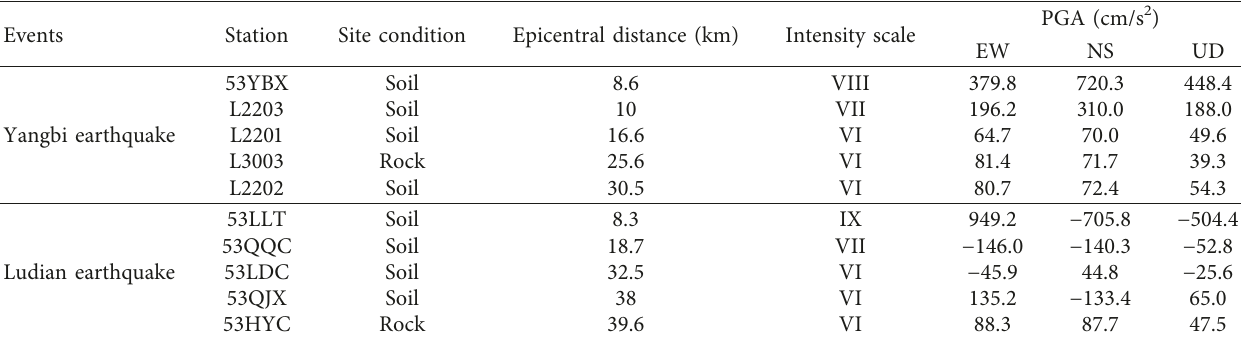
Table 1: Basic information of strong motion stations in the study.